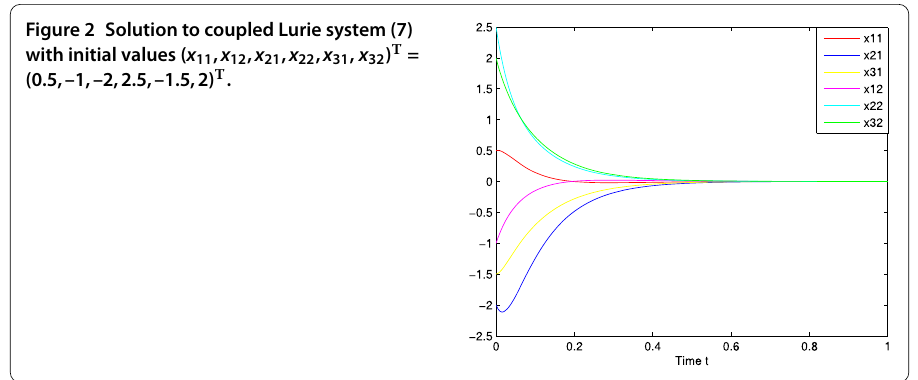
Figure 2 Solution to coupled Lurie system (7) with initial values ( x 11 , x 12 , x 21 , x 22 , x 31 , x 32 ) T = (0.5,–1,–2,2.5,–1.5,2) T